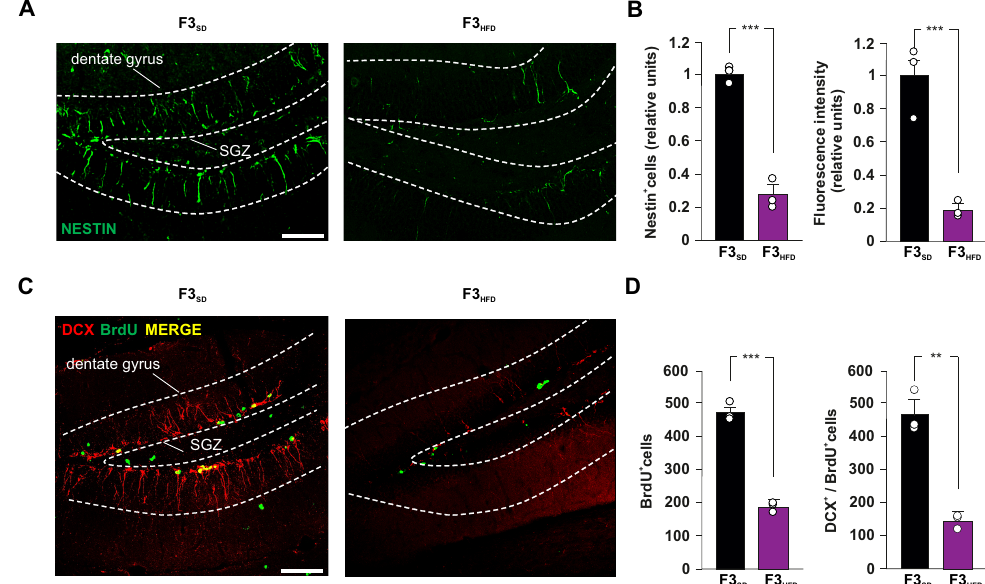
Figure 3. Ancestor HFD impairs adult hippocampal neurogenesis in F3 HFD descendants. ( A ) Repre- sentative images of Nestin + cell immunostaining in hippocampal slices containing the SGZ of F3 SD and F3 HFD male mice ( n = 3 mice per group; n = 6 slices per animal; statistics by unpaired Student’s t -test). Scale bar = 50 µ m. ( B ) Bar graphs showing the change of Nestin + cell number (left) and